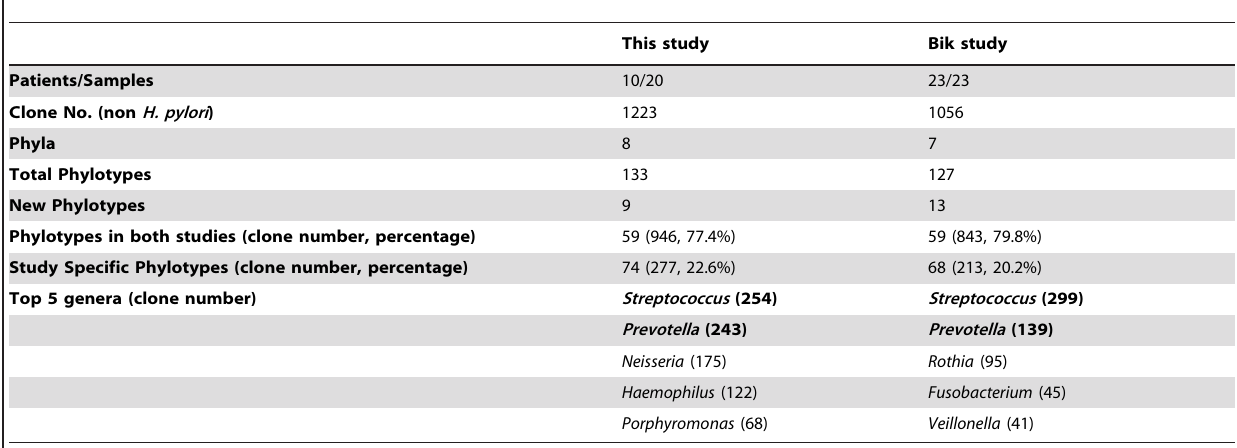
Table 3. Comparison between this study and the Bik